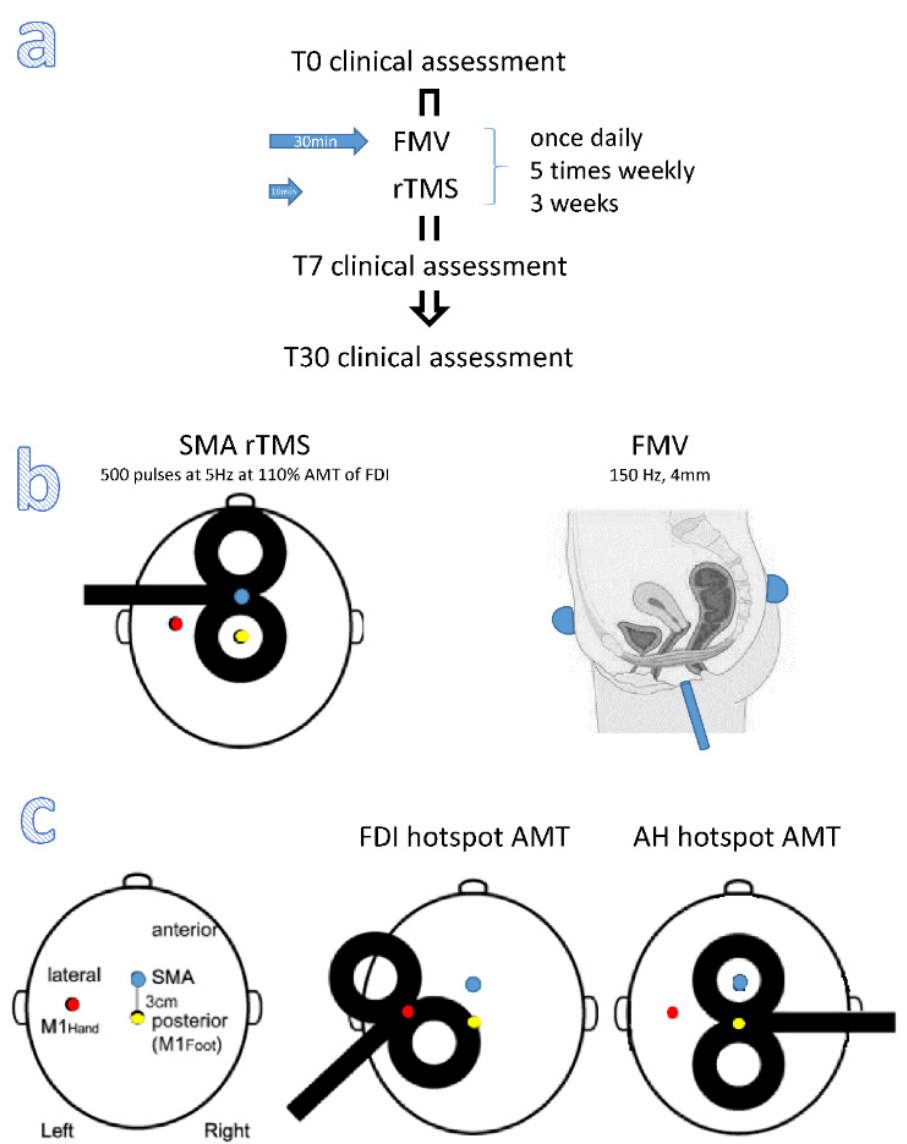
Figure 1. ( a ) Experimental study design. ( b ) SMA rTMS site and cup-like and pen-like probe sites for FMV. ( c ) Single-pulse TMS stimulation sites. Legend: AH: abductor halluces; AMT: active motor threshold; FDI: first dorsal interosseous; FMV: focal muscle vibration; M1: primary motor cortex; rTMS: repetitive transcranial magnetic stimulation; SMA: supplementary motor area; T0: baseline; T30: follow-up visit 30 days after the end of the stimulation protocol; T7: follow-up visit seven days after the end of the stimulation